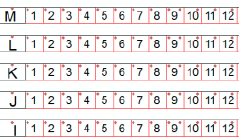
Figure 1: Data from facilities management